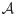
Supra-additive double ablations.The combined effect of each two neuron ablation is compared against the additive effect of the corresponding two single ablations. The results of Quantile Regression of CV of the pair against the averaged CV of the two single ablations (see Section ‘Detecting supra-additive double-node deletions’) are shown for: (a) Partition A and (b) Partition D. The top 1% pairs with the largest supra-additive effect are found above the quantile scores QA>0.9835 and QD>0.965, respectively. These top 1% double ablations are dominated by: (c) interneurons for A; (d) motor neurons for D. Overrepresentation of neurons in the top 1% supra-additive pairs for (e) Partition A and (f) Partition D was calculated using a one-sided Fisher exact test (unadjusted p-values are reported, and also provided for all neurons in the S1 Dataset). Neurons with p < 10−5 are listed and the names of neurons are coloured according to their type: S (blue), I (red), M (yellow). The word clouds are a visualisation of these over-representations. Computing a Bayesian quantile of higher prevalence of these neurons among the top 1% pairs also supports these findings [48].